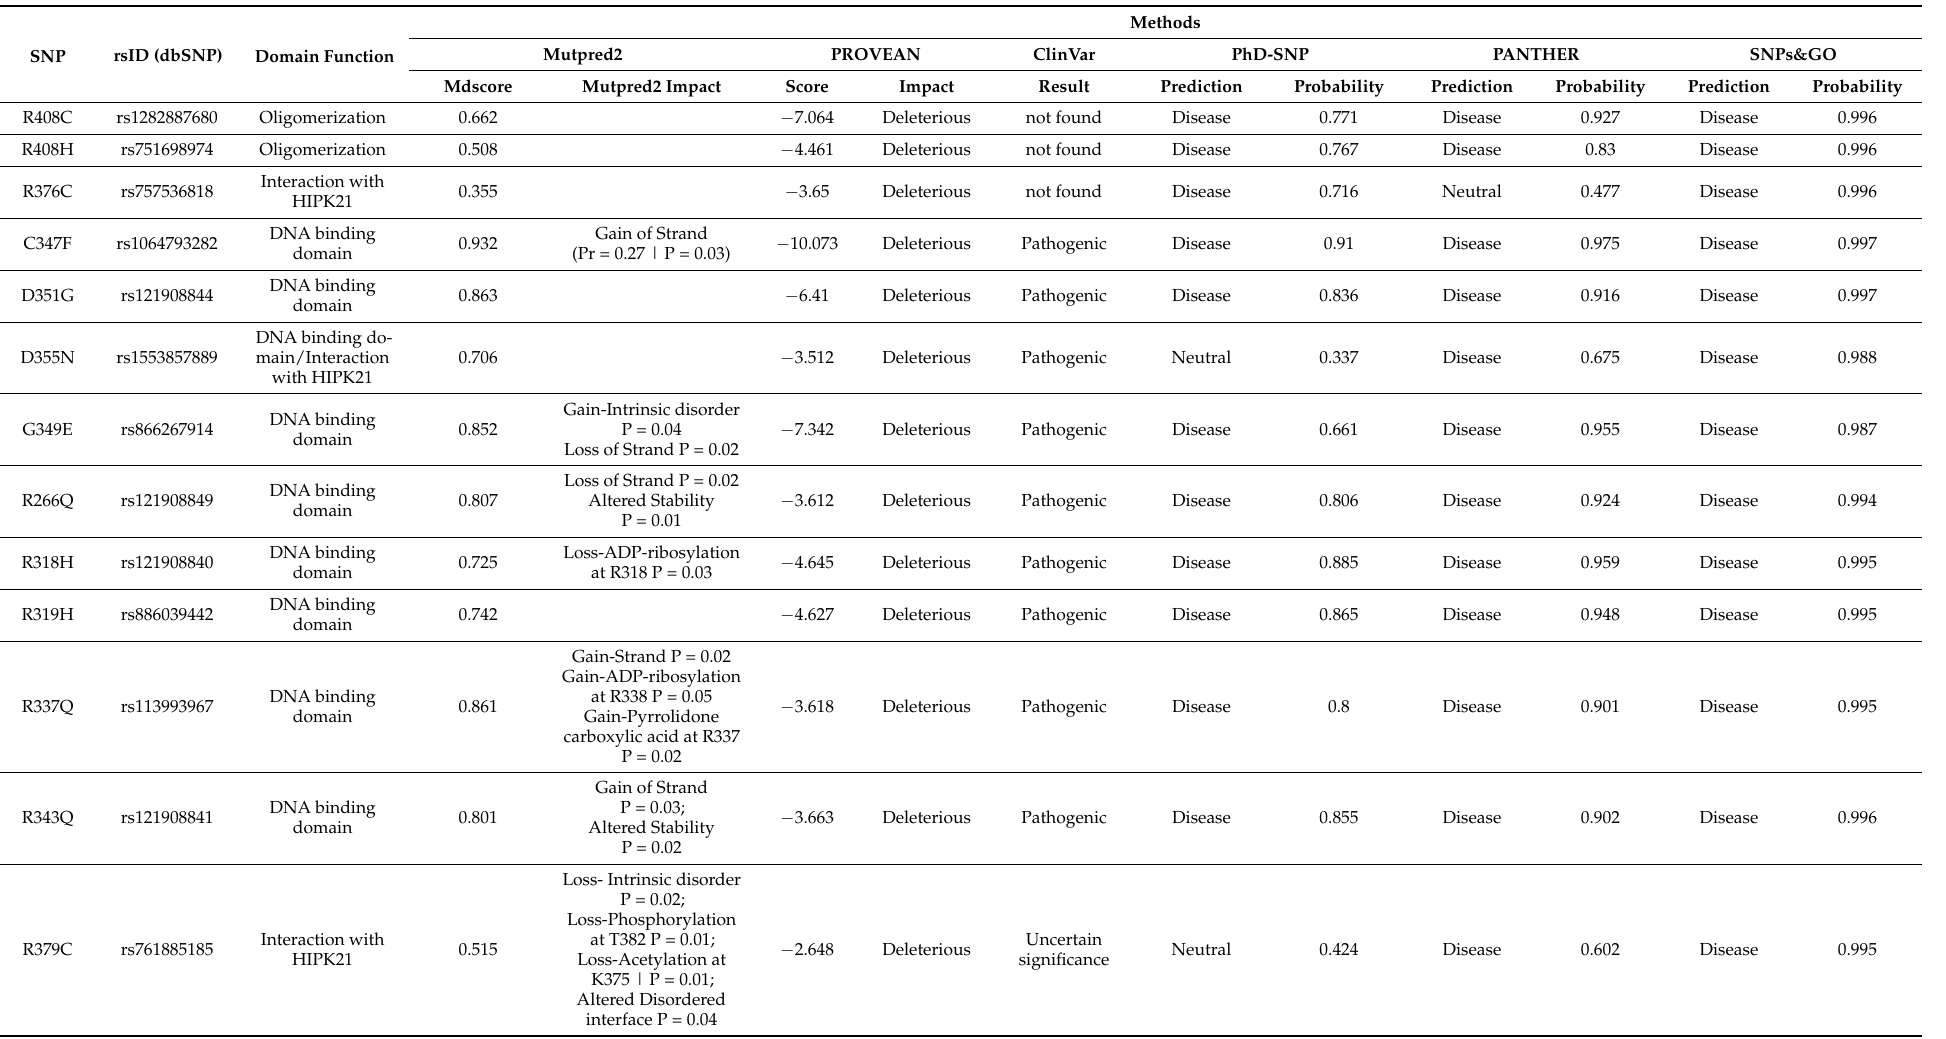
Table 1. Prediction of 17 SNPs with PROVEAN, ClinVar, PhD-SNP, PANTHER,